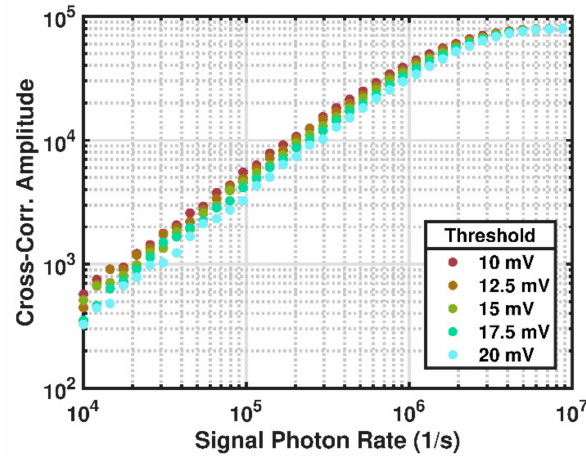
Figure 7. Cross-correlation amplitude as a function of incident signal photon rate for 100 Hz measurement rate. For these simulations, the detector dark noise and solar background noise levels were set to zero.